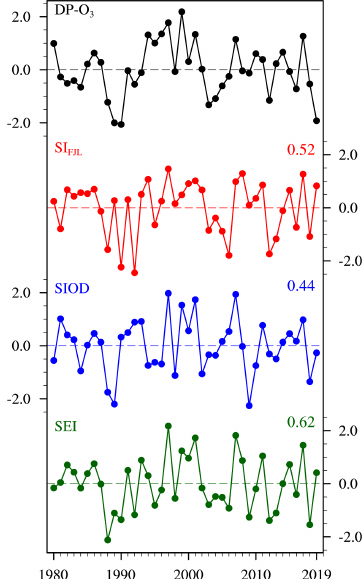
Figure 2. Variations in standardized DP-O 3 time series (black), May SI near Franz Josef Land (SI FJL , red), January–February– March mean Subtropical Indian Ocean Dipole (SIOD, blue), and SEI (green) from 1980 to 2019. SEI is defined as the weighted av- erage of SI FJL and SIOD. The correlation coefficients of the DP-O 3 with SI FJL (red), SIOD (blue), and SEI (green) were shown in the figure.